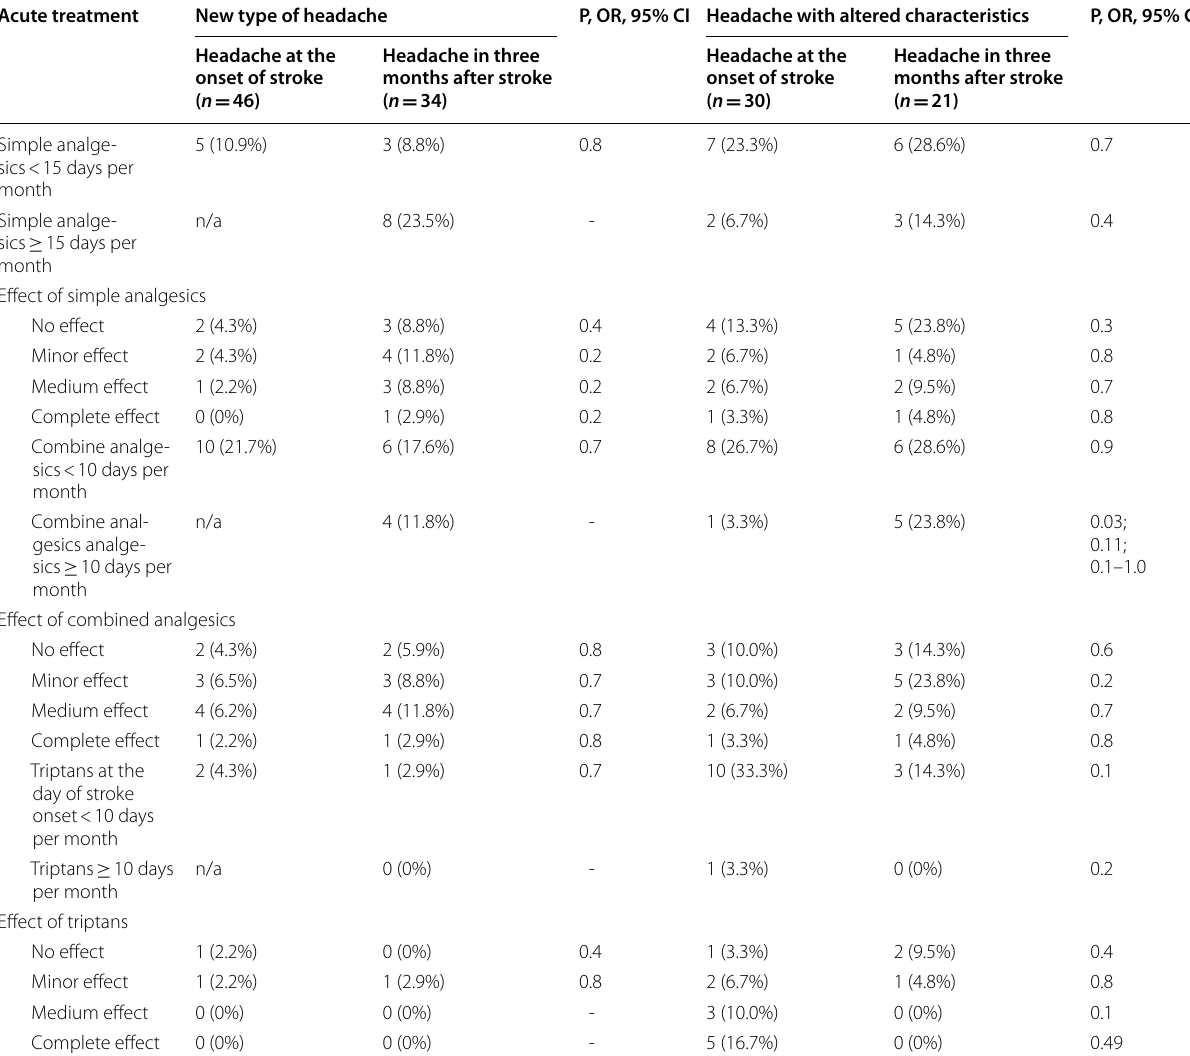
Table 3 Medical drugs for pain relief and their effect in patients with headache in three months after first-ever ischemic stroke compared to acute treatment of headache at onset of stroke Acute